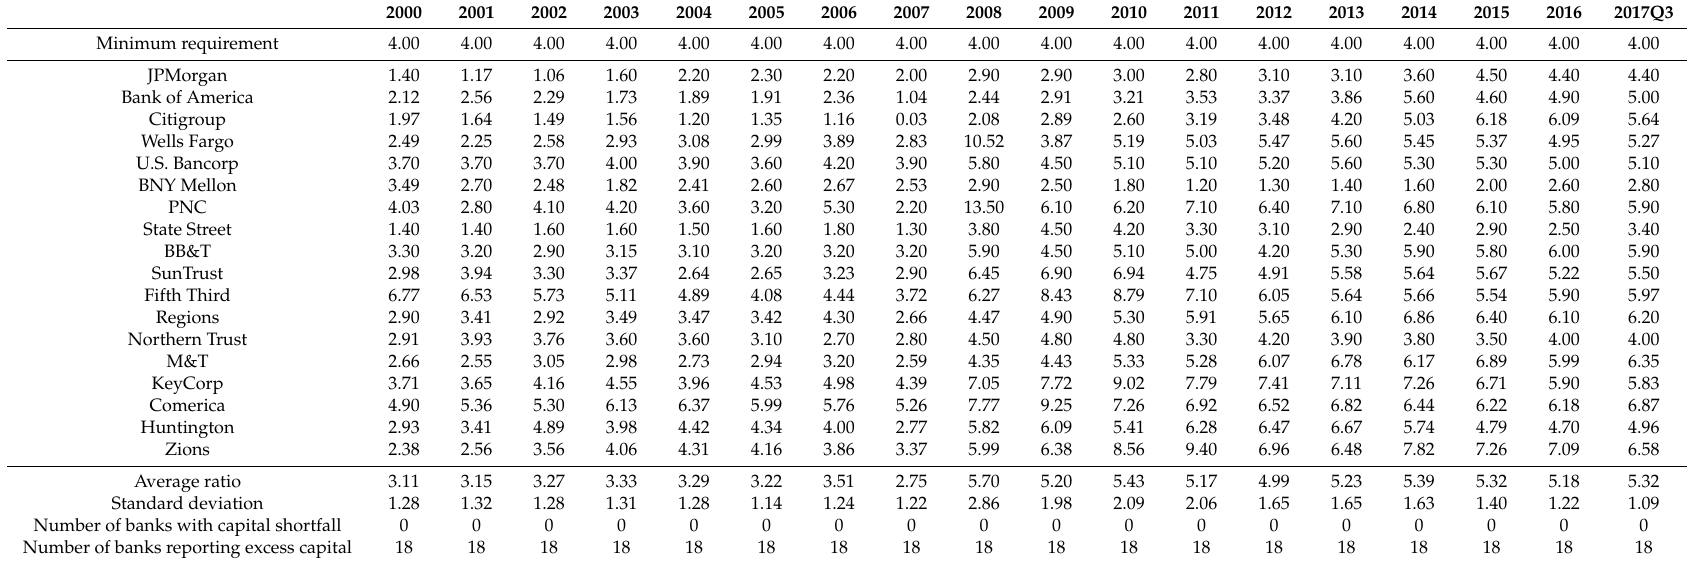
Table A4. Actual Leverage Ratio Minus Required Minimum Leverage Ratio of 4